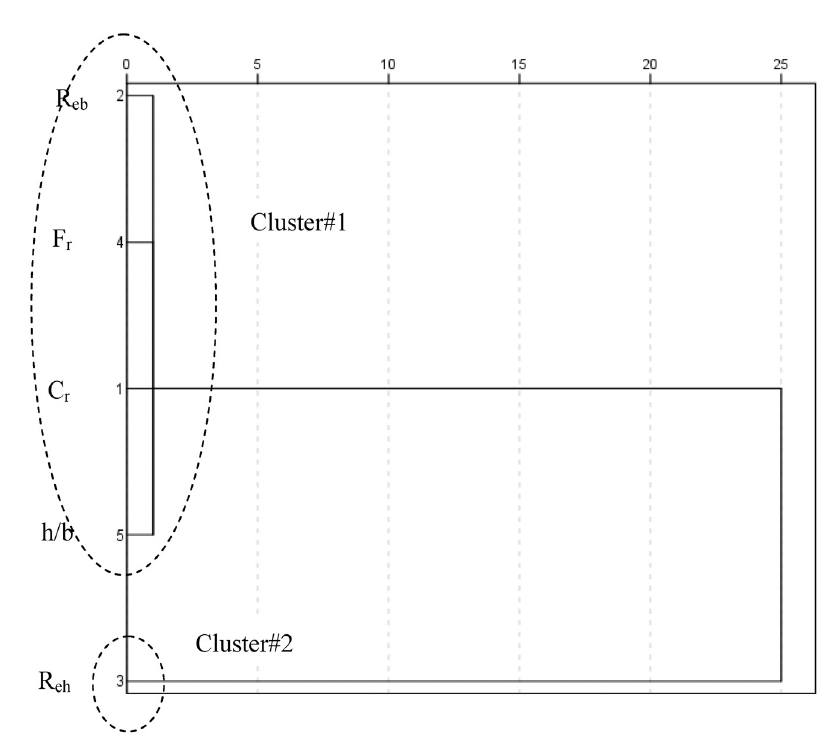
Figure 1. Dendogram using Ward